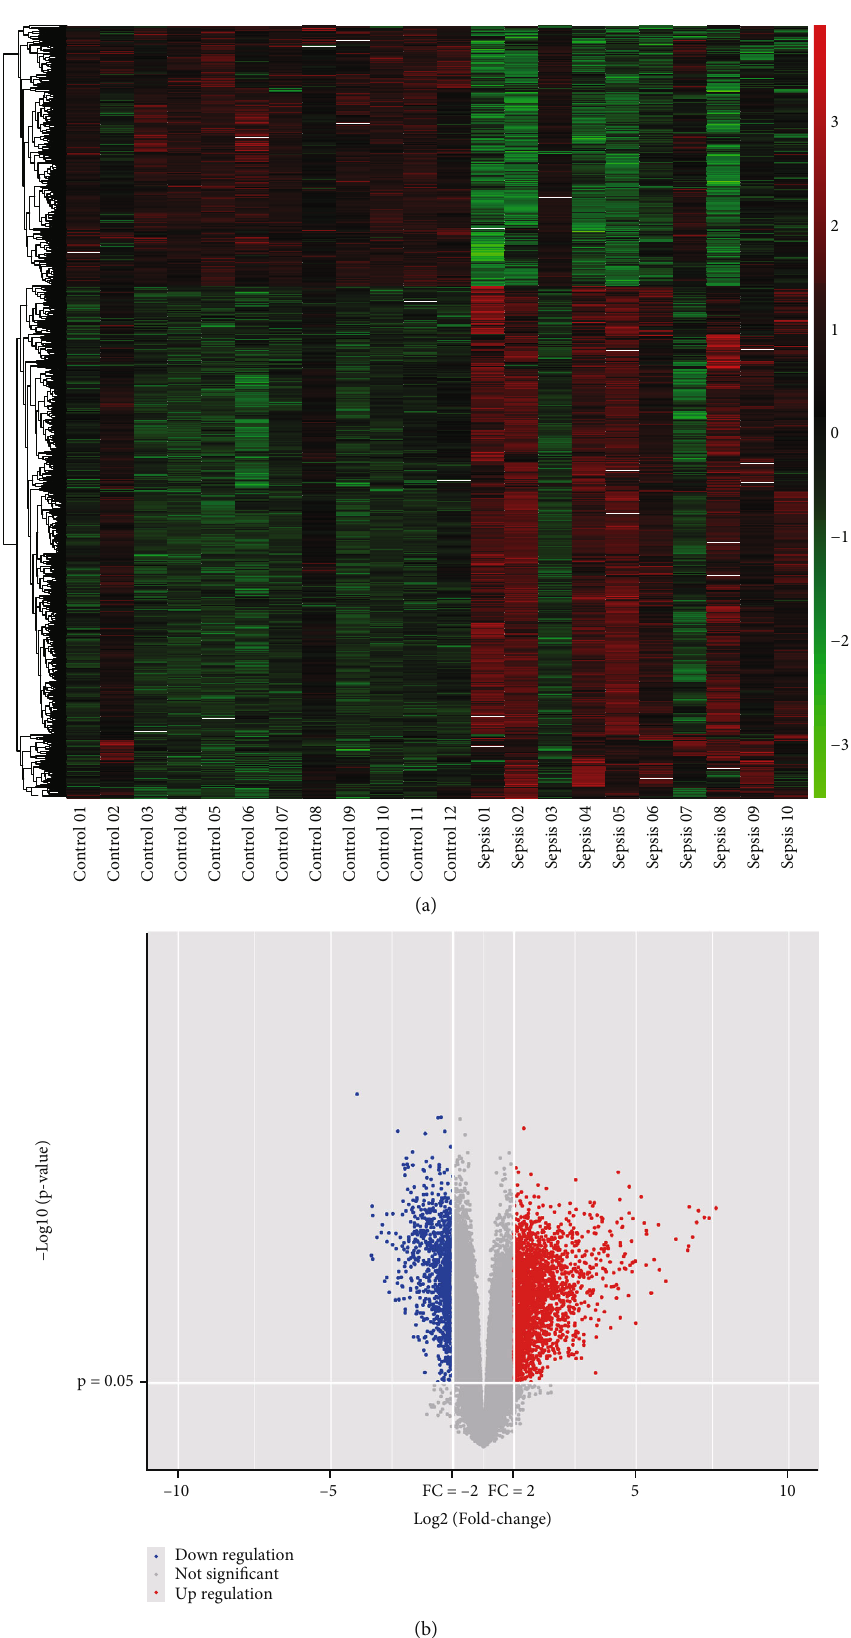
Figure 1: lncRNA DEGs analysis. (a) Heat map and (b) volcano map illustrations of di ff erential